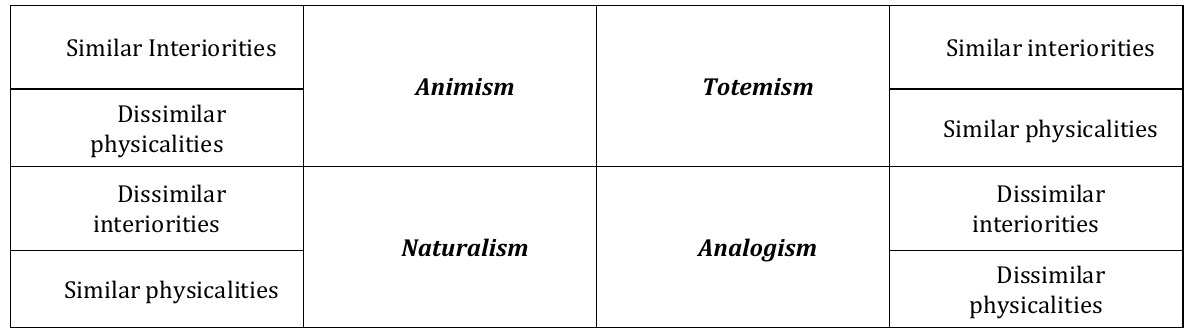
Table. 1. Four Ontologies of Descola (2013, p. 67)